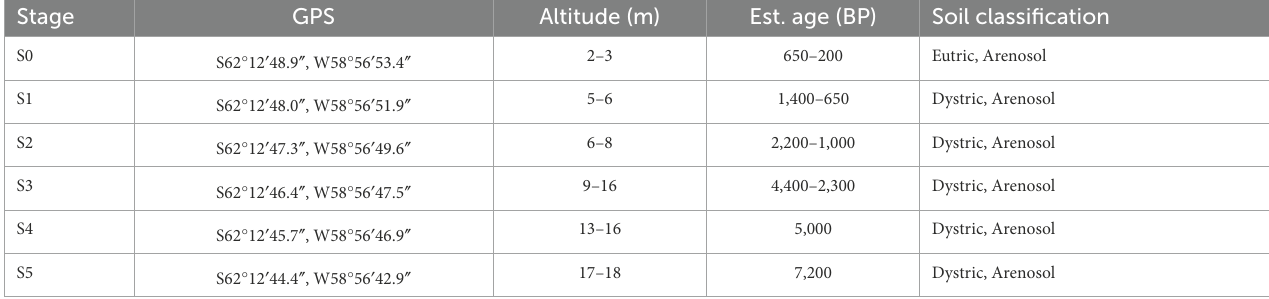
TABLE 1 Local parameters and soil properties of sampled soil sites along the Ardley Island temporal gradient (Boy et al., 2016).